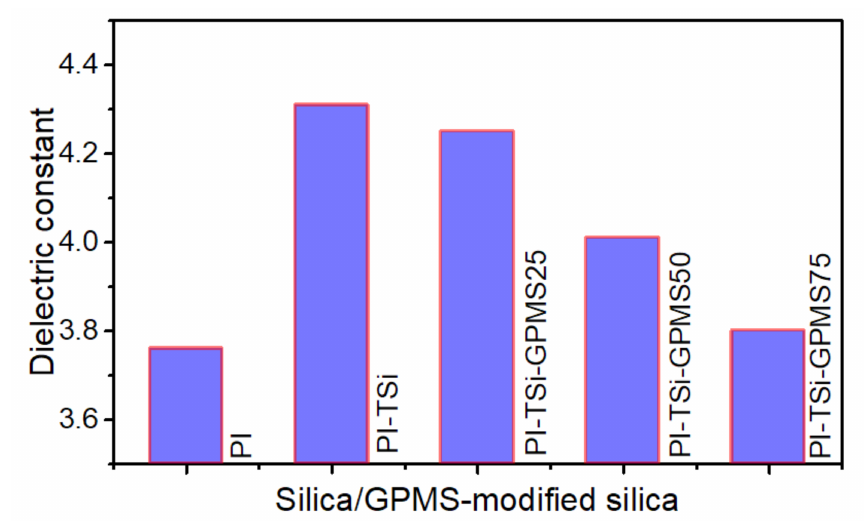
Figure 8. Effect of silica and GPMS-modified silica on the dielectric constant of